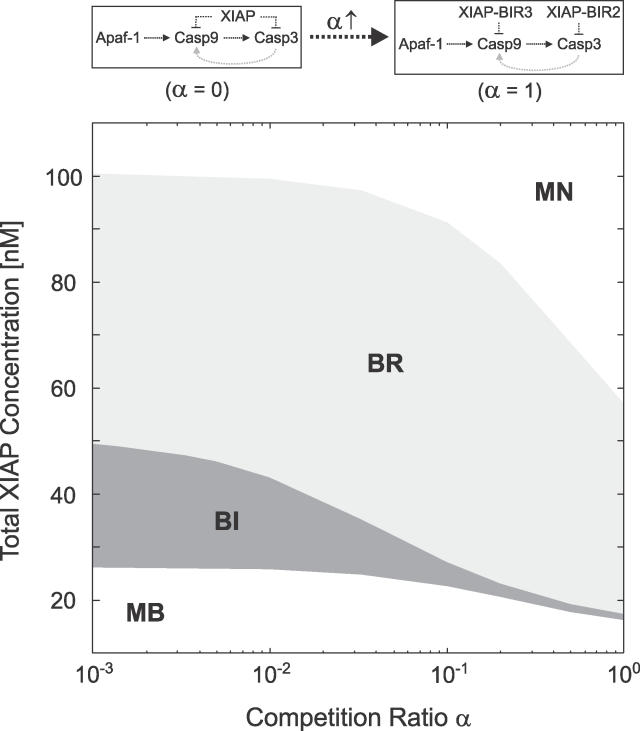
Determinants for Bistability and Irreversibility IIThe qualitative behaviour of caspase activation according to Figure 4A–4E is shown as a function of the XIAP level, and of the competition ratio α. The competition ratio α (Protocol S1) equals the fold-change in XIAP's affinity for Casp9 brought about by Casp3 binding to XIAP (and vice versa), and thereby quantifies the degree of competitive caspase binding to XIAP as indicated on the top.